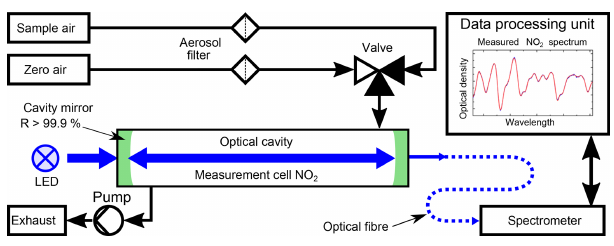
Figure 7. Schematic drawing of the ICAD